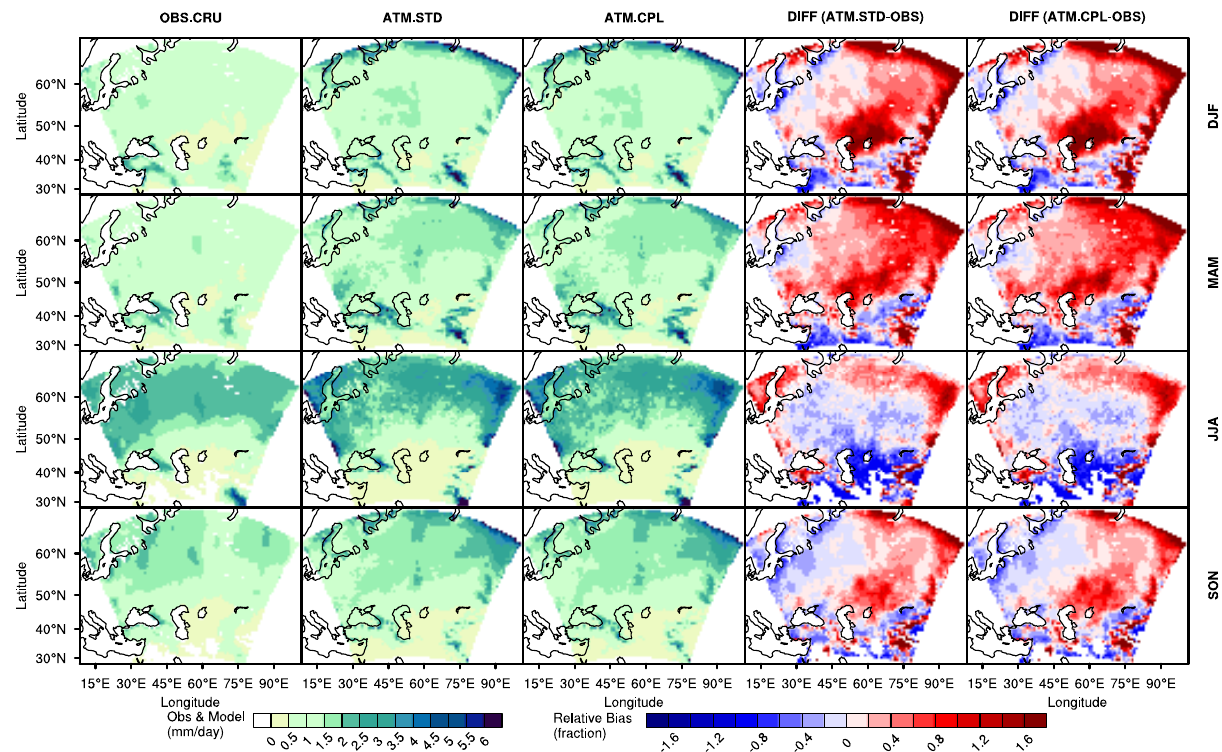
Fig. 6. Seasonal precipitation climatology of ATM.STD, ATM.CPL simulations and observation (CRU version 3.10), along with the corre- sponding relative biases for the period 1999–2008.